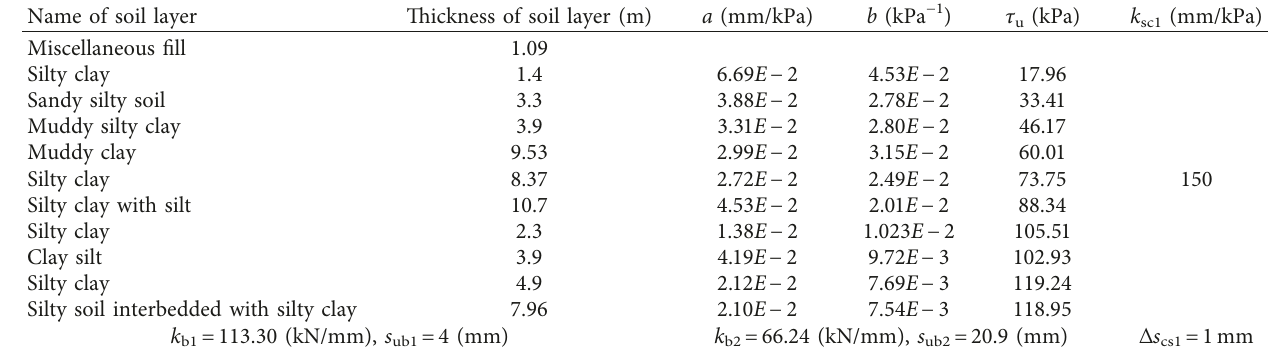
Figure 11: Calculation model for pile settlement analysis. Table 3: Soil profile and parameters for the tested